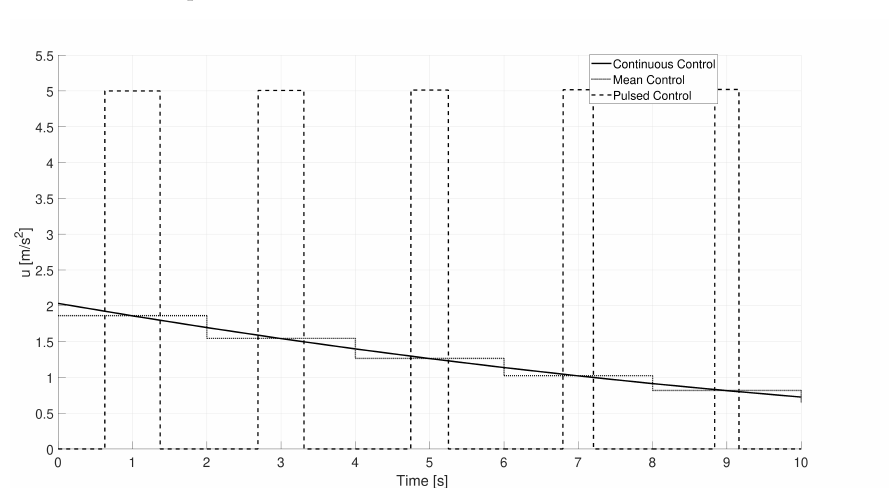
Figure 7. PWM representation.